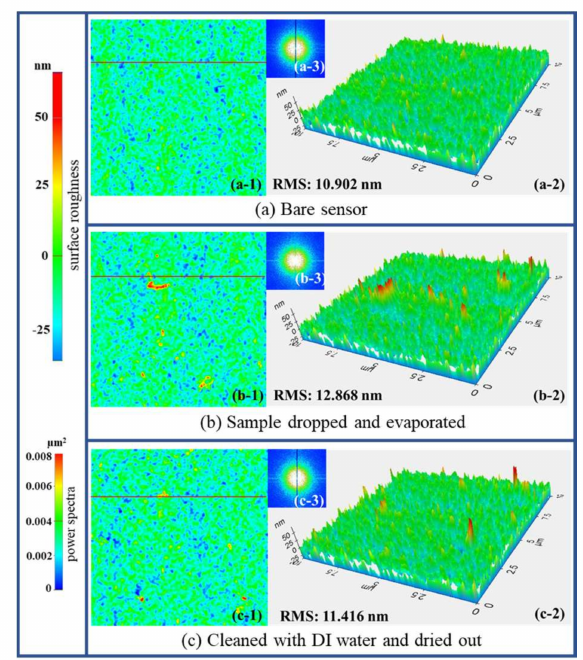
Figure 7. Surface morphological study of the sensor under three sequential conditions. ( a ) Bare chip, ( b ) the water-ethanol solution (containing 30% ethanol) was dropped in the sensing region and allowed to evaporate for 5 min, and ( c ) the surface was cleaned with DI water and then dried. The two-dimensional surface morphology is shown in subfigures (a-1) to (c-1), and the corresponding three-dimensional surface is shown in subfigures (a-2) to (c-2). The power spectra obtained by Fourier transform shown in subfigures (a-3) to (c-3) reveals no significant variation in power at all three conditions.